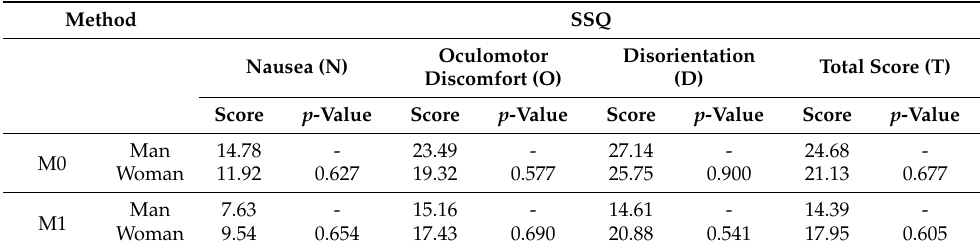
Figure 8. Comparing SSQ score of VR sickness reduction methods. Table 3. The difference in the level of VR sickness depending on gender.